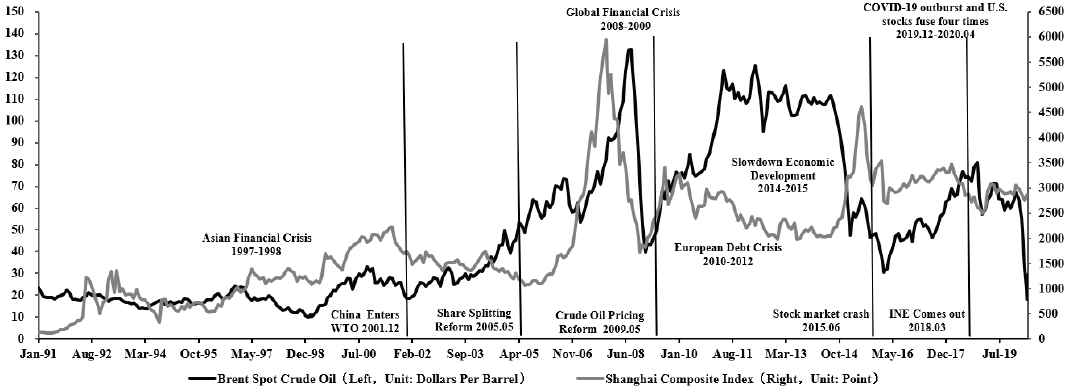
Figure 1. Brent spot price and the Shanghai Composite Index.